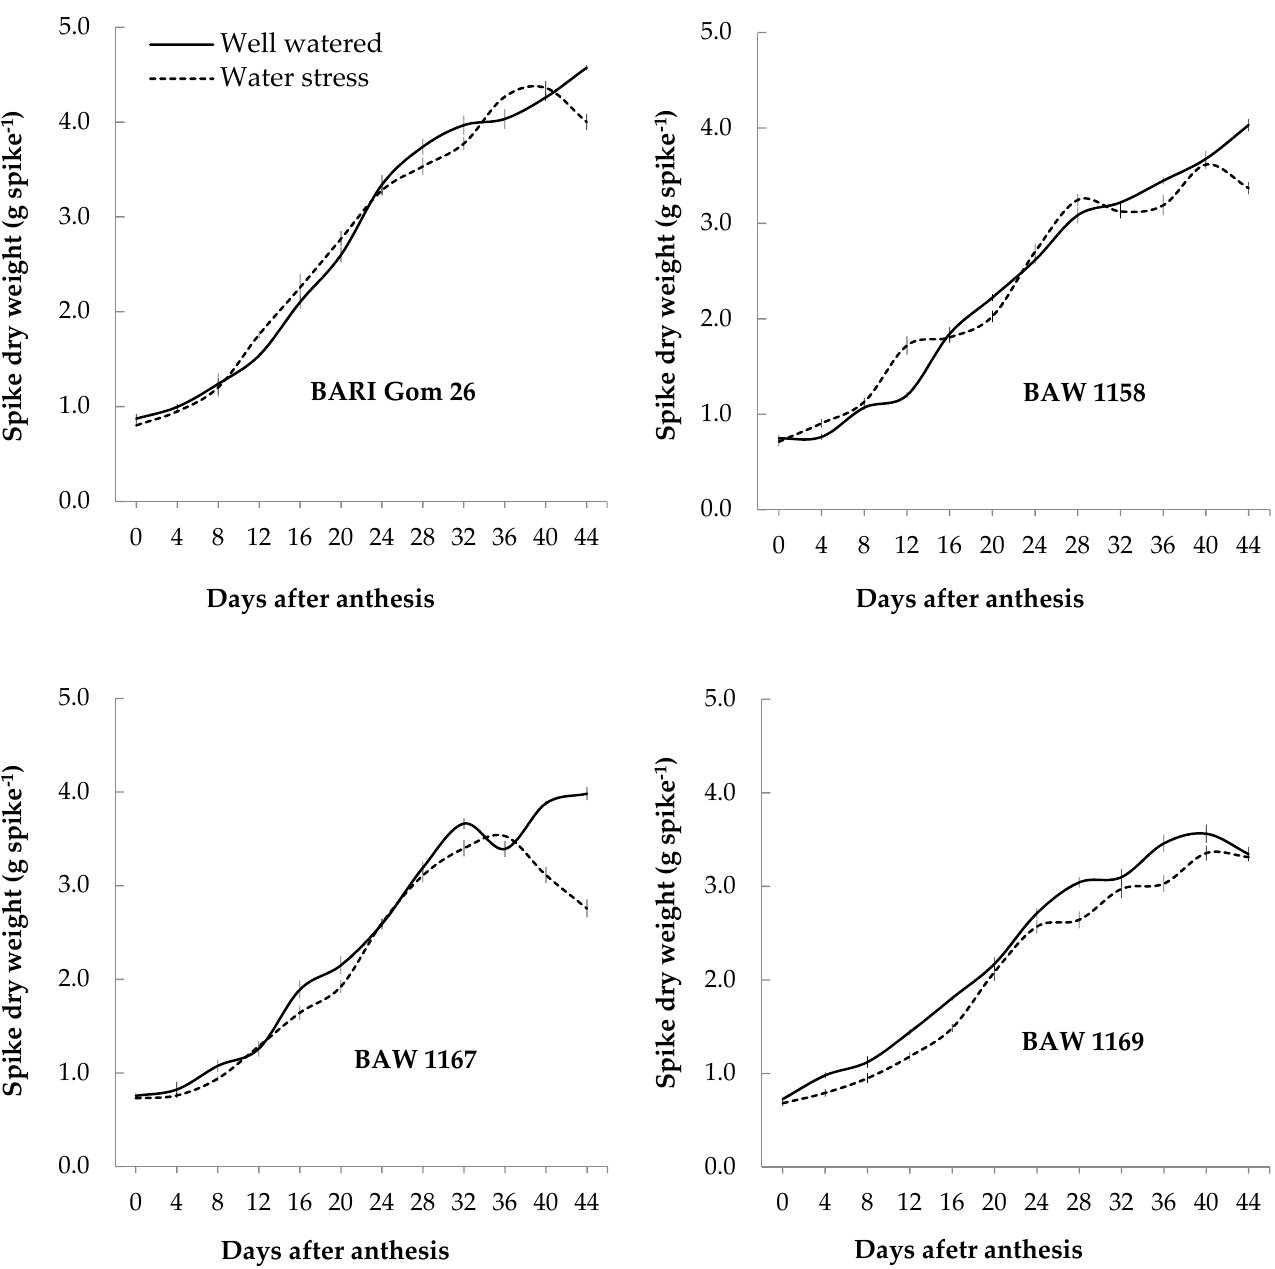
0.01.02.03.04.05.0 Figure 1. Effect of DS on the spike dry weight of different wheat genotypes at different DAA.